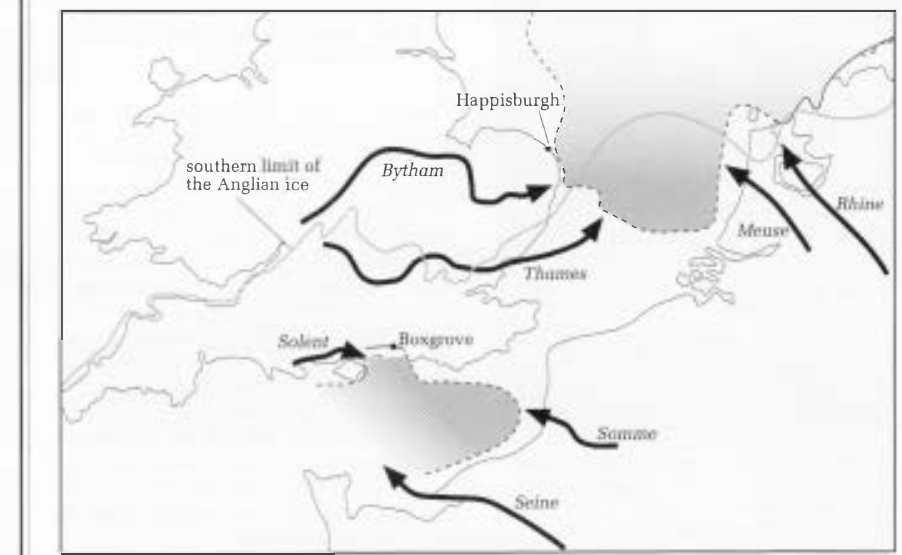
Figure 5 Main features of the pre-glacial palaeogeography of southern Britain during the Anglian glaciation, showing the major rivers, the land bridge, and the location of the archaeological sites of Happisburgh and